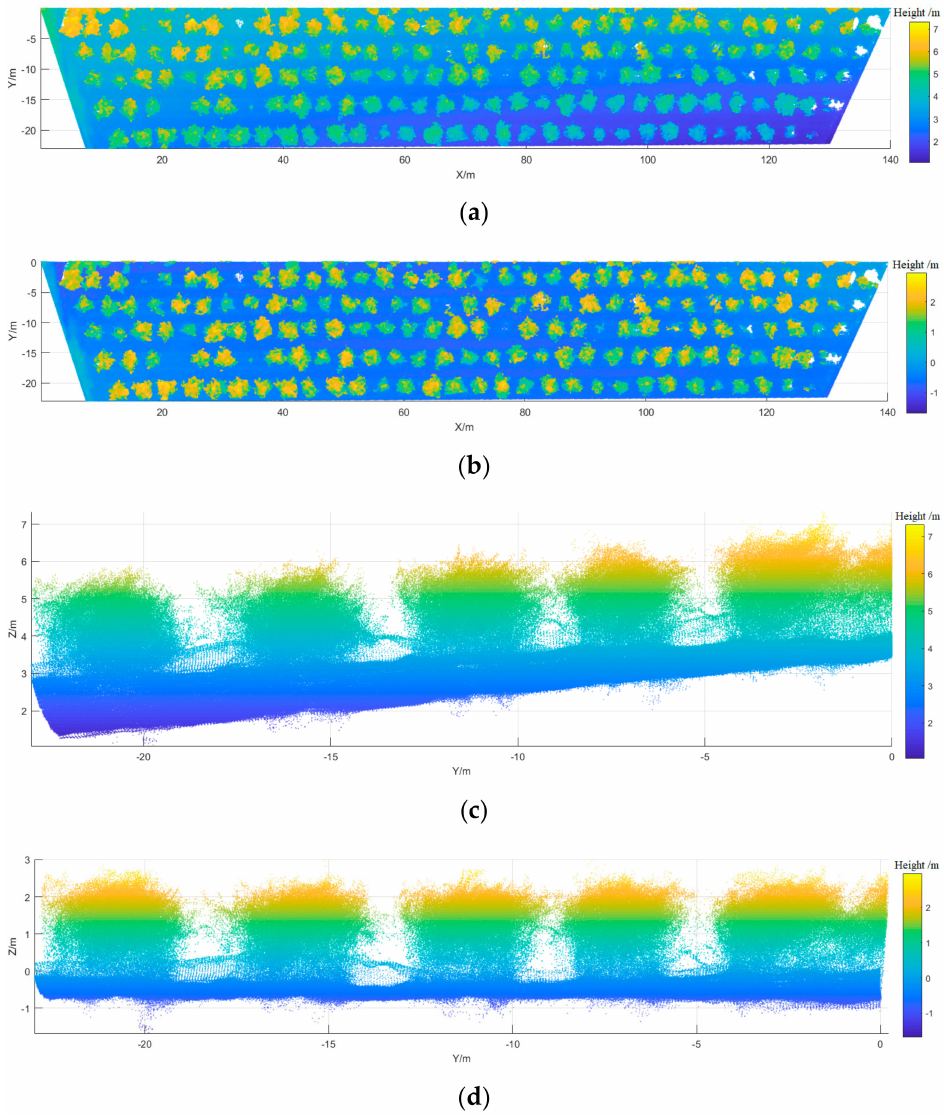
Figure 4. Slope correction of the orchard point-cloud model. ( a ) Orchard point-cloud model before correction (XOY plane view); ( b ) Orchard point-cloud model after correction (XOY plane view); ( c ) Orchard point-cloud model before correction (YOZ plane view); ( d ) Orchard point-cloud model after correction (YOZ plane